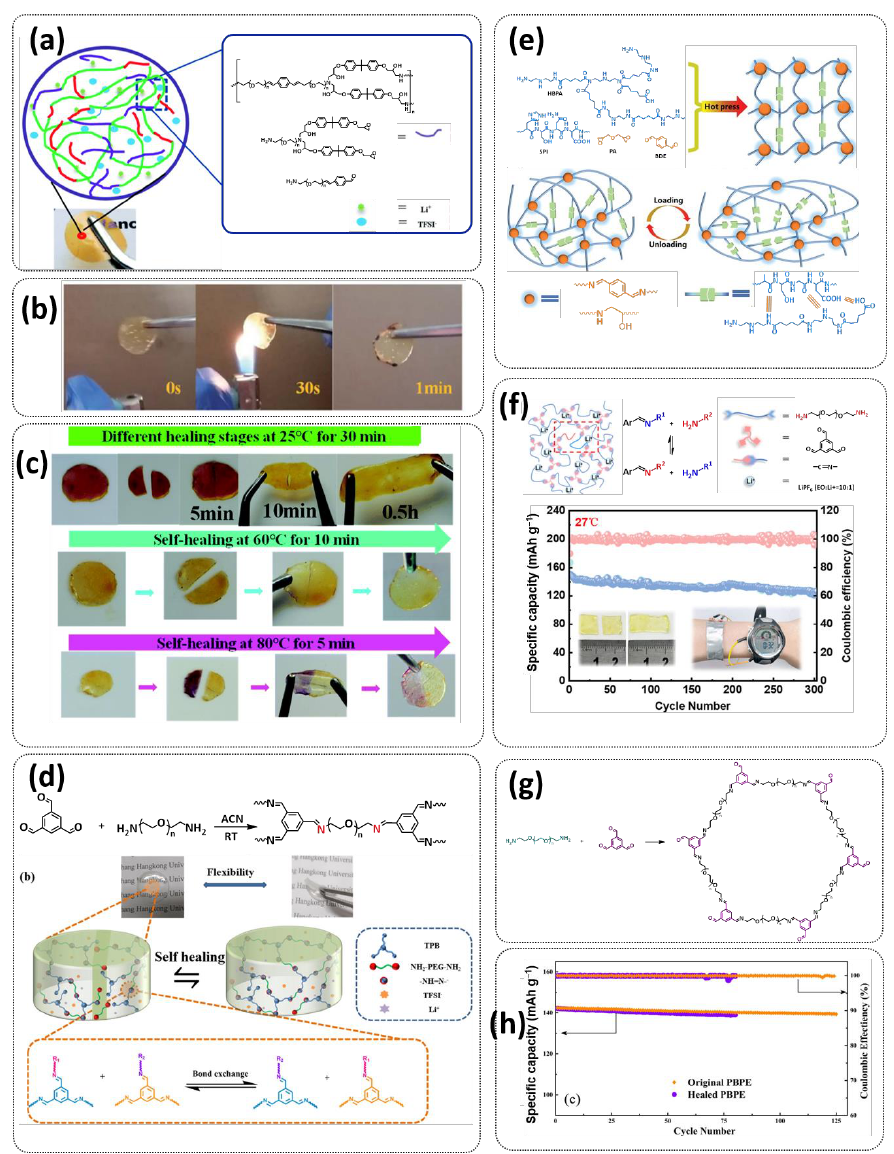
Figure 6. ( a ) Schematic illustration of the ShSPE-3 network. ( b ) Flammability test of ShSPE-3. ( c ) Self-healing behavior of ShSPE-3 at different temperatures. Reproduced from [78] with permission from the Royal Society of Chemistry. ( d ) Synthesis of crosslinked polymer and schematic diagram of the self-healing process of shCLSPE-3400. Reproduced with permission from [85]. Copyright © 2022, Society of Industrial Chemistry. ( e ) Preparation of the dynamic covalent networks of SPI-based vitrimer and schematic illustration of the energy dissipation mechanism through reversible breaking and reformation of hydrogen bonds under deformation. Reproduced with permission from [80]. Copyright © 2022 The Authors. Advanced Science published by Wiley-VCH GmbH. ( f ) Supramolecular structure and self-healing mechanism based on dynamic imine bonds for the SHSPE. The long-term cycling performance of the Li|SHSPE|LiFePO4 cell at 0.1C. Intercepts: self- healing behavior and flexible Li|SHSPE|LiFePO4 pouch cell. Reproduced with permission from [73]. Copyright © 2021, American Chemical Society. ( g ) Synthesis of PBPE. ( h ) Cycle performances of LFP/original PBPE/Li cell and LFP/healed BPE/Li cell at a 1C rate. Reproduced with permission from [74]. Copyright © 2021 Elsevier B.V. All rights